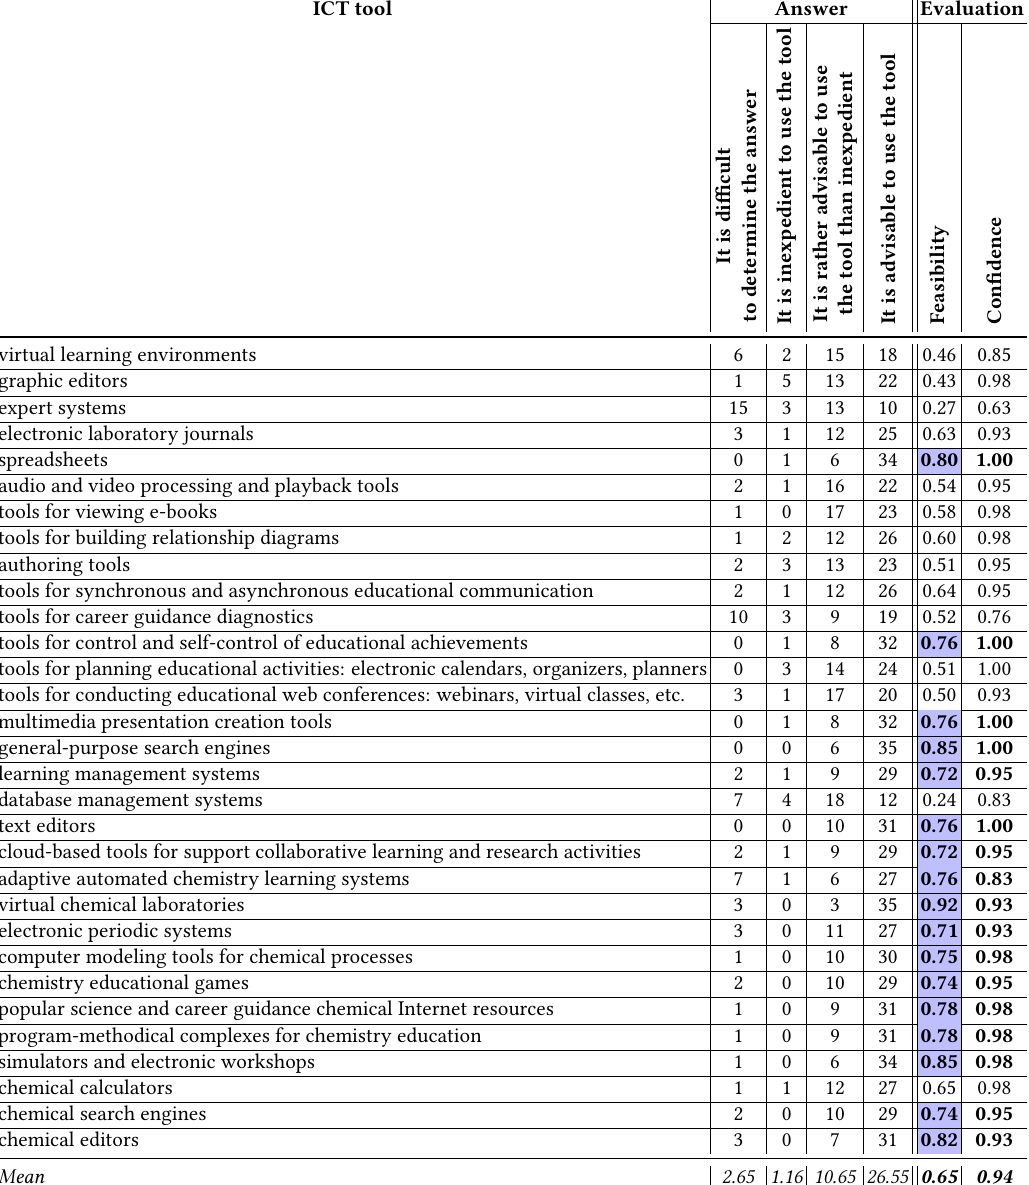
Table 3 The results of expert evaluation of the using feasibility of ICT tools for the development of students’ research competencies in specialized chemistry